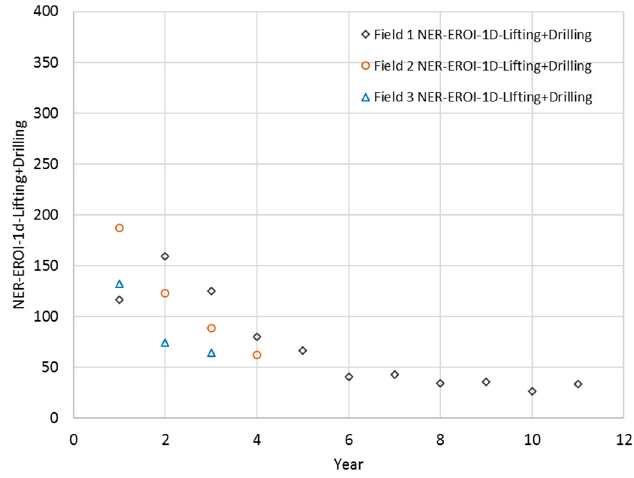
Figure 7. NER-EROI-1d Lifting + Drilling for three fields.